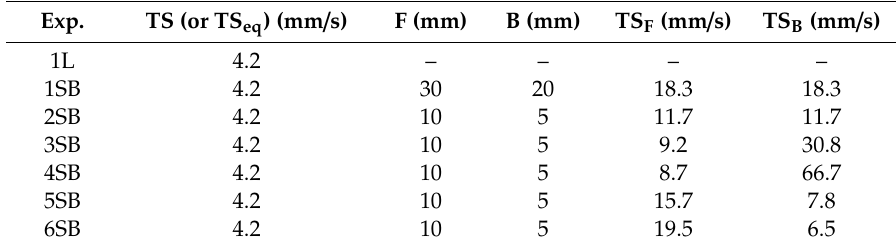
Table 2. Experimental planning (pulsed GMAW, 1.2 mm ER70S-6, CTWD of 18 mm, Ar + 5% O 2 and I m = 145 A).